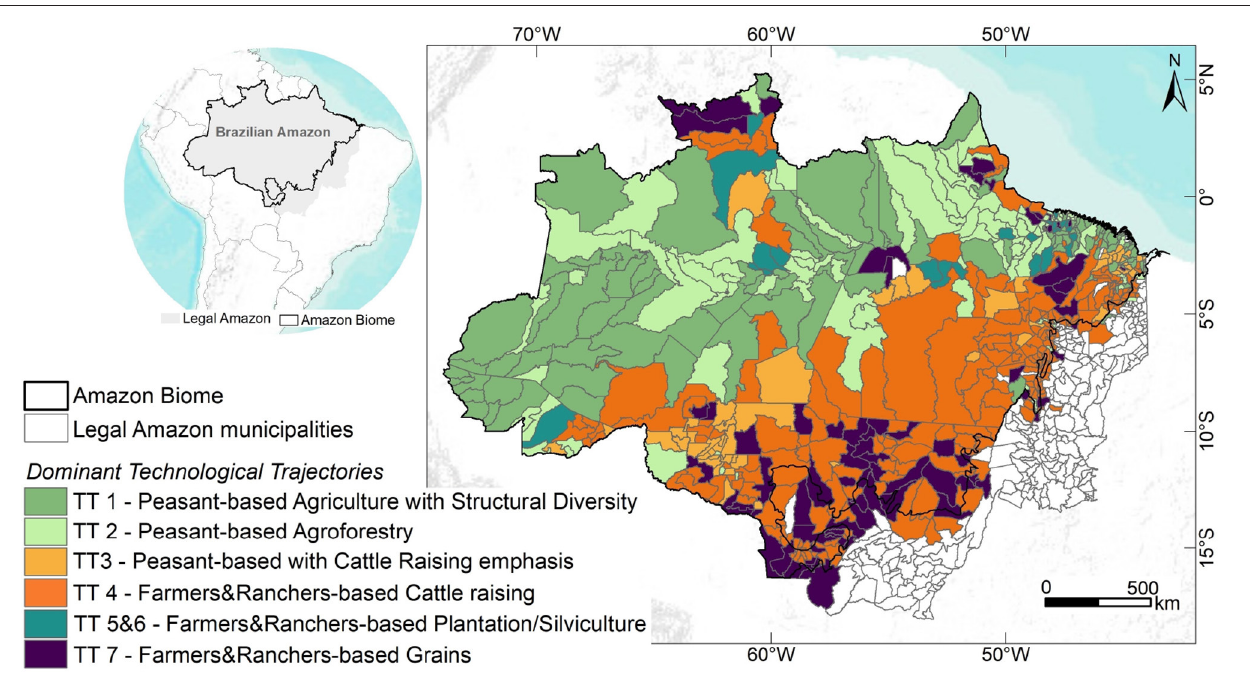
FIGURE 1 | Dominant Technological Trajectories (TT) in Amazon biome municipalities in 2017. The inset highlights the limits of the Brazilian Amazon (Amazon Biome and Legal Amazon).